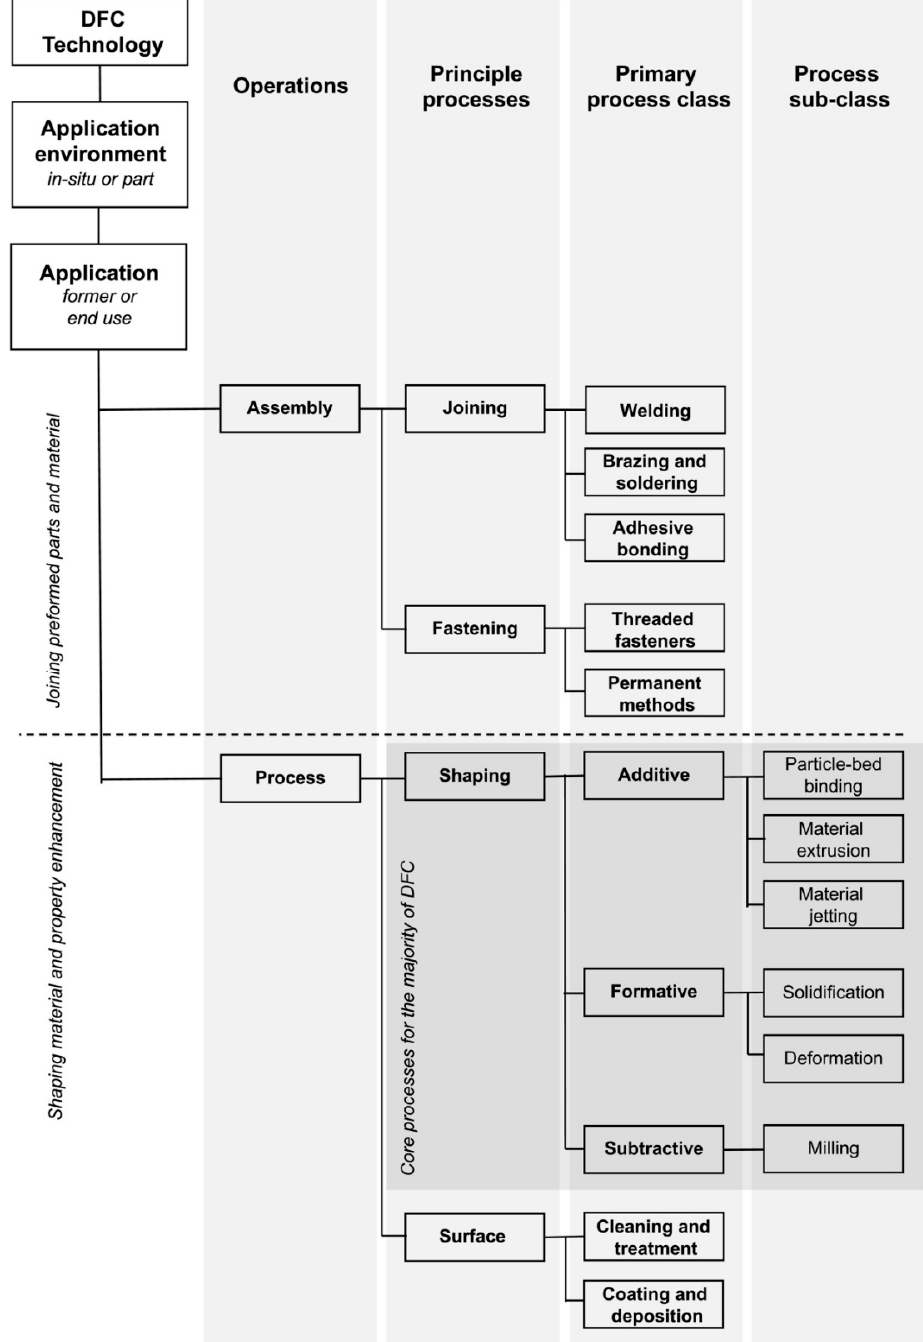
Figure 1. The process classification framework of DFC technologies proposed by [1].